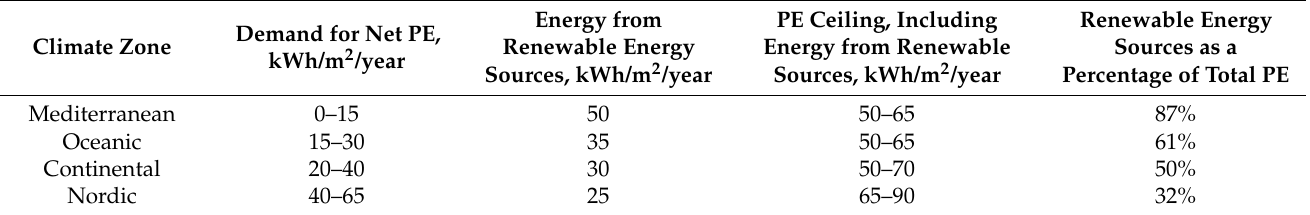
Table 2. European Commission standards of building performance and renewable energy resources for different climate zones [13].